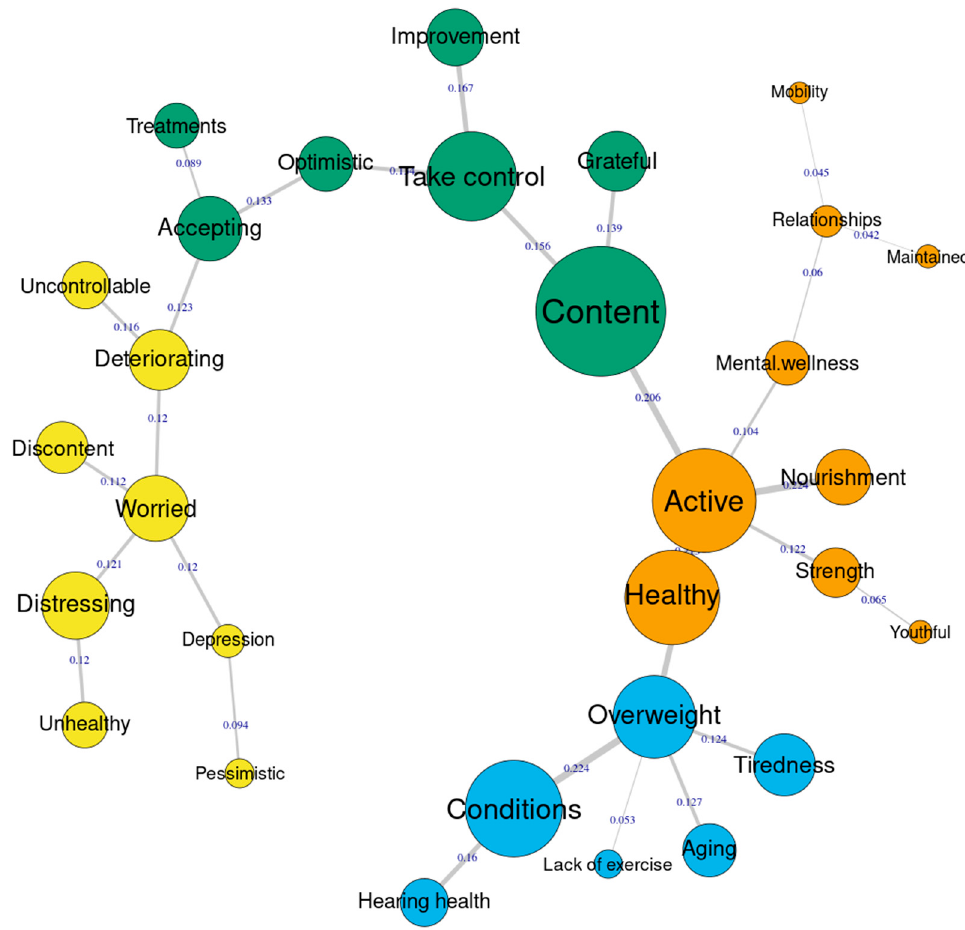
Figure 3. Similarities analysis index for health responses.